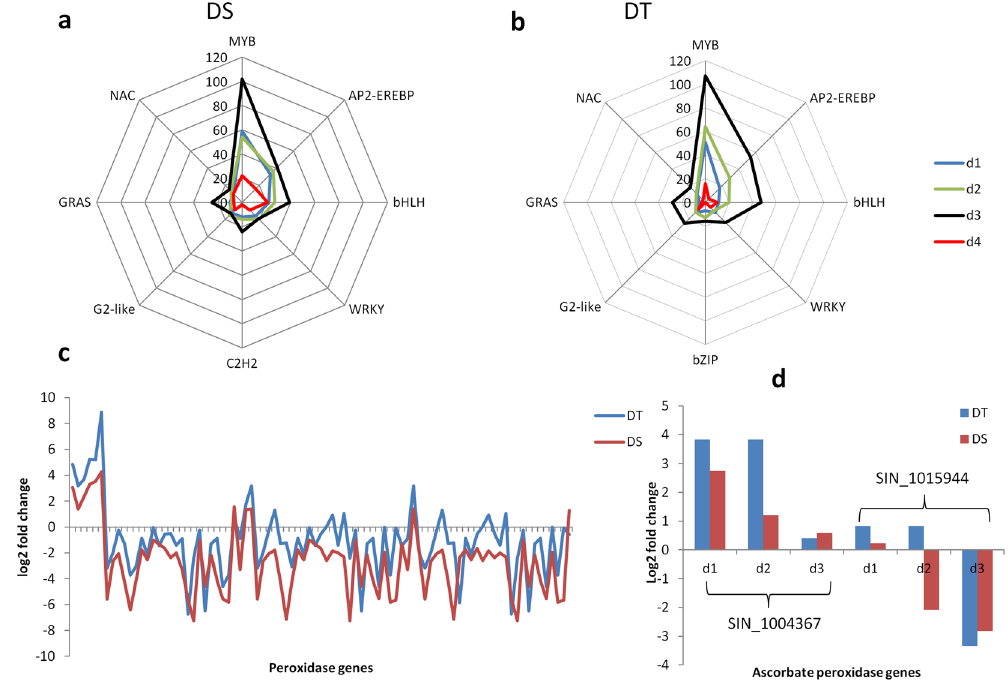
Figure 8. Major transcription factors and pathways involved in sesame drought response. Major transcription factors from DEGs in ( a ) sensitive (DS) and ( b ) tolerant (DT) sesame genotypes, ( c ) log 2 fold change in peroxidase gene expression in DT and DS under drought stress, ( d ) log 2 fold change in ascorbate gene expression in DT and DS under drought. d 0 , d 1 , d 2 , d 3 and d 4 : data from plants stressed for 0, 3, 7, 11 days and 3 days of recovery after rewatering,